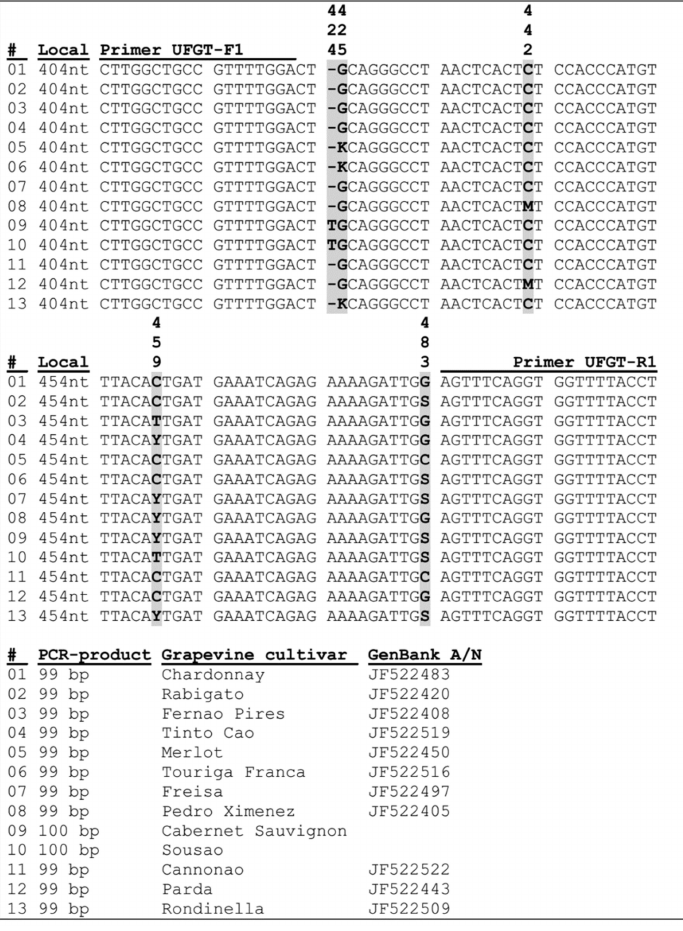
Figure 8. Alignment of reference nucleotide sequences of the Vitis vinifera L. UFGT gene locus flanked with UFGT-F1 and UFGT-R1 primers. # index number.